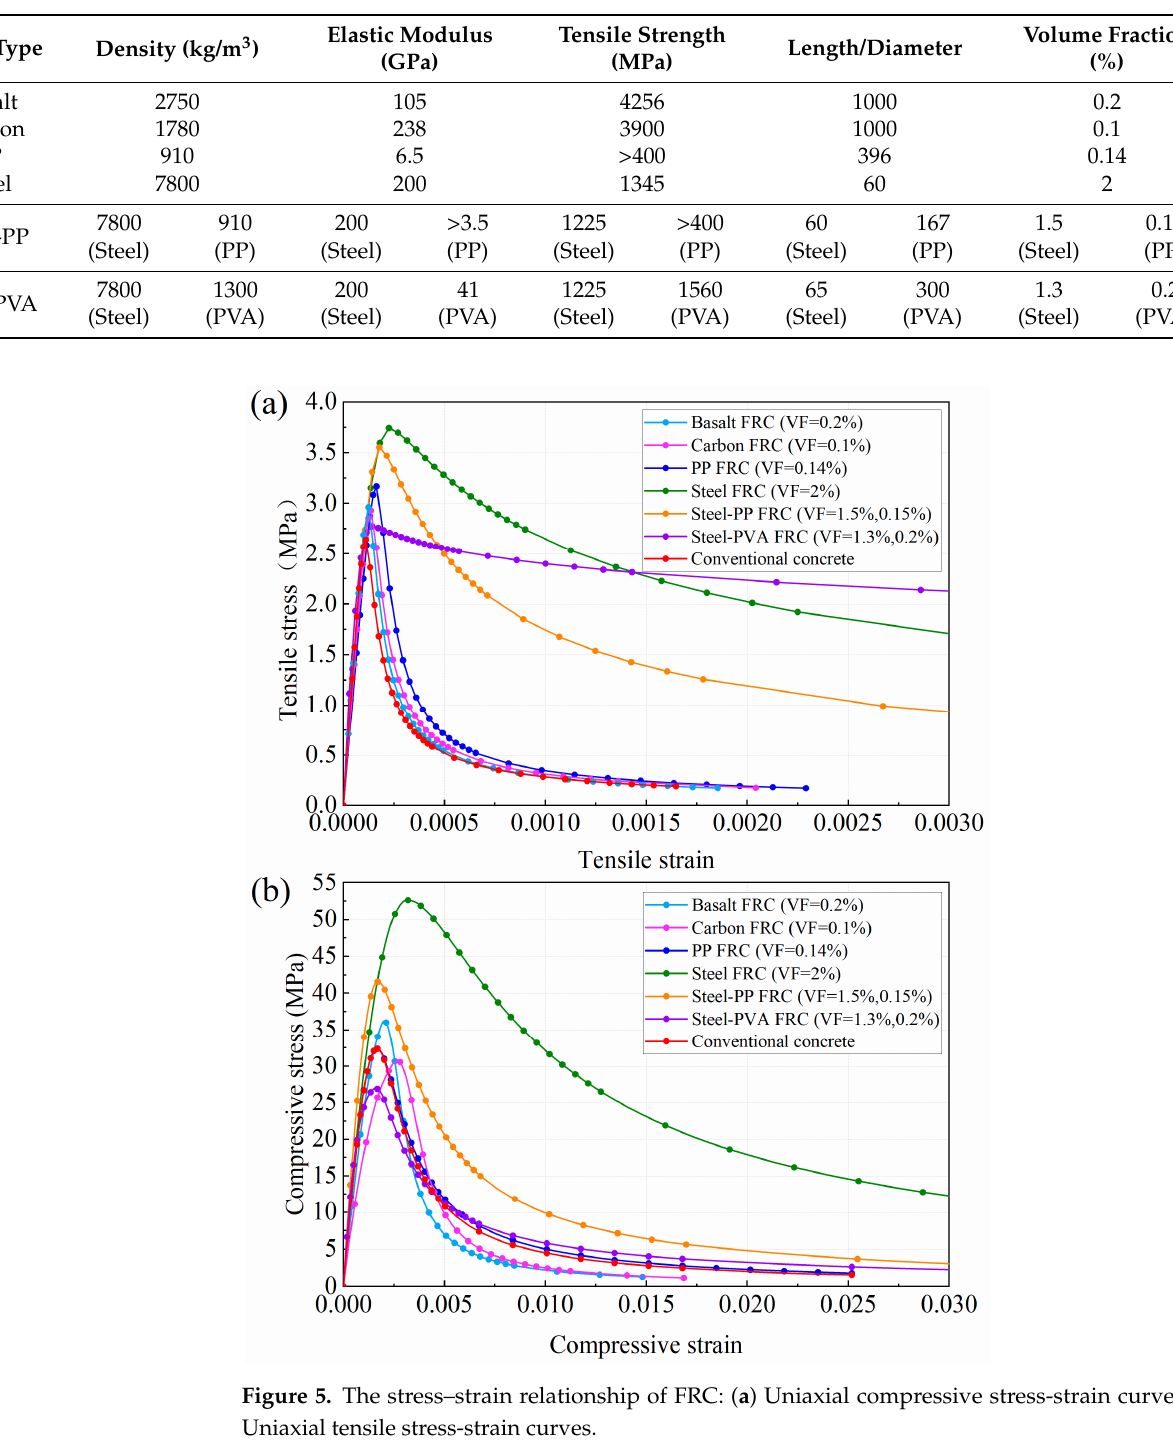
Table 3. Properties of selected fibers.